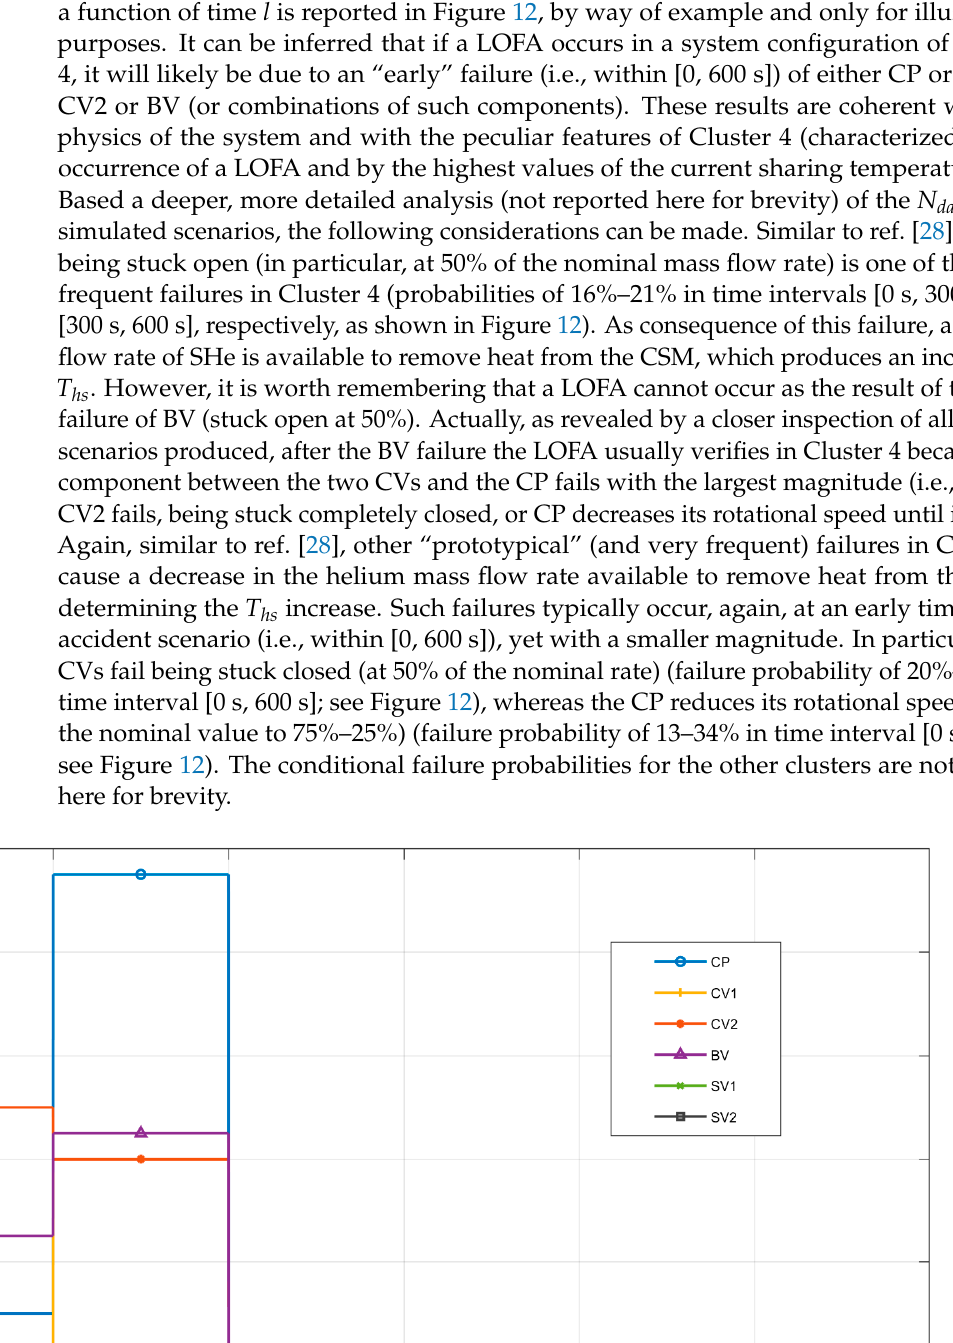
( e | c ) of each component e for cluster c = 4, as a function of time l FAIL , l